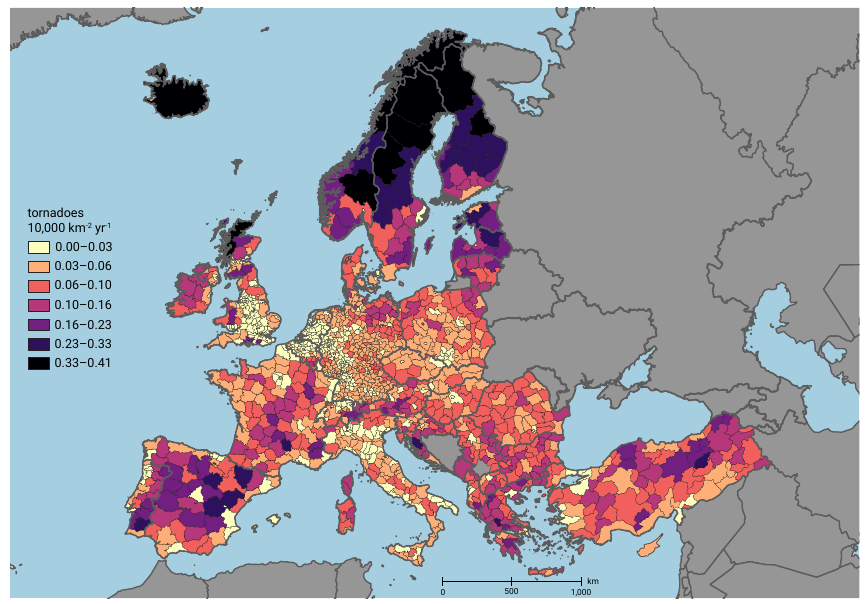
Figure 1. Difference between posterior adjusted number of tornadoes and the number of ob- served tornadoes normalized by the area of NUTS3 regions and year (shaded according to the scale, 10,000 km − 2 yr − 1